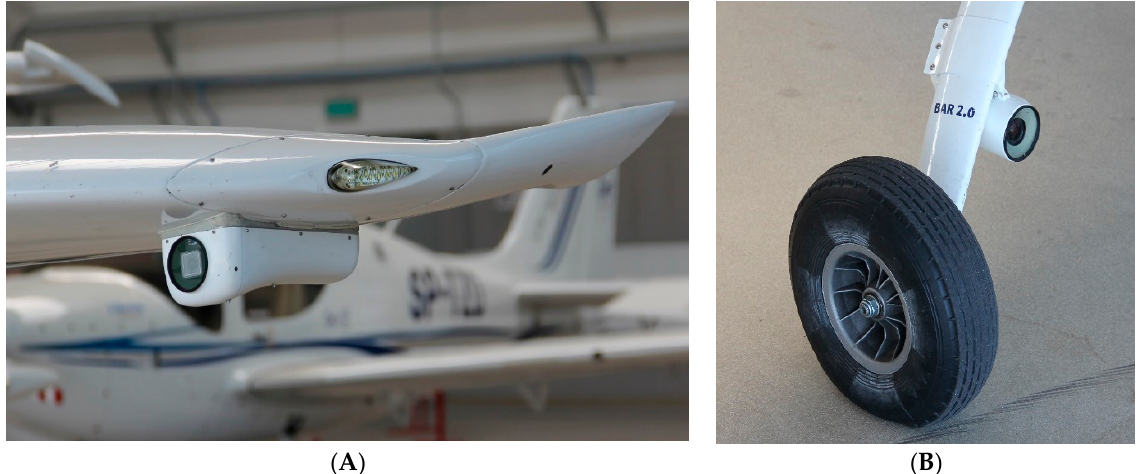
Figure 4. Observation sensor mounted in container under left wing ( A ); and camera installed on the right chassis ( B ).